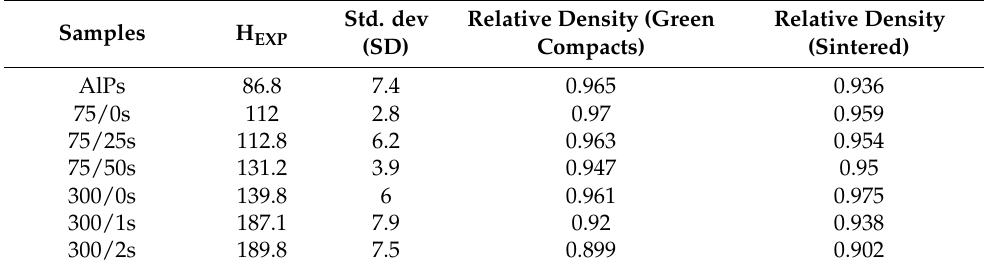
Table 3. Microhardness experimental results H EXP and standard deviation (SD) for all